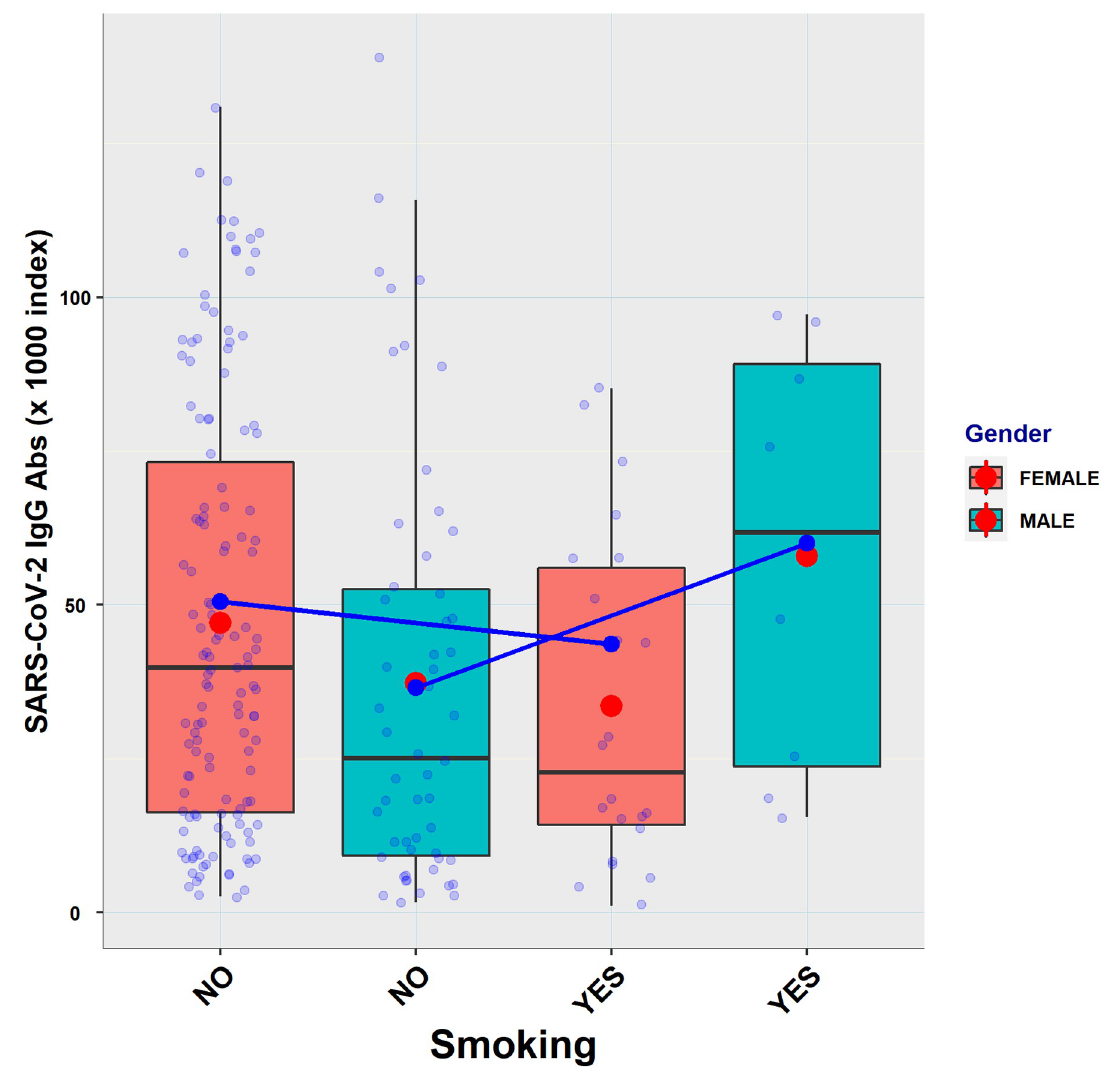
Fig 3. Boxplots of antibody titers of the two sampling periods (n = 220) shown by smoking and gender, and interaction lines between the two factors (p = 0.024). Horizontal black lines show the median; red dots show the sample means; filled blue dots show titer estimation determined by the model; open blue dots represent sample values. Random jittering was applied to help visualization of overlapping points.